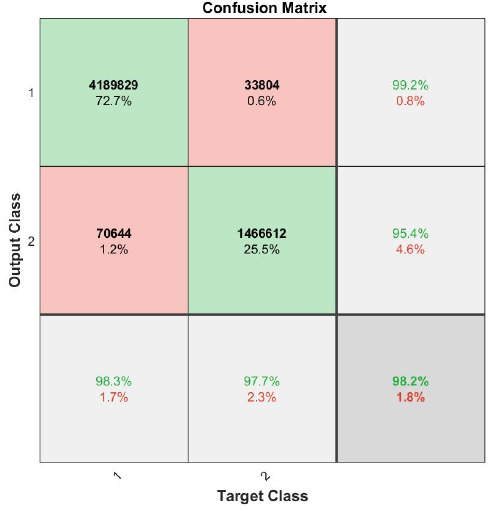
Figure 12. MWR SIE Arctic confusion matrix.